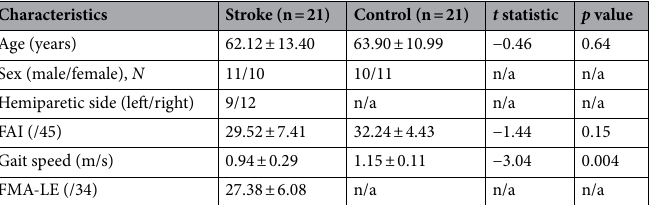
Table 1. Participant characteristics. All data is presented as mean ± standard deviation. FAI Frenchay activities index, FMA-LE Fugl-Meyer assessment of lower extremity, n/a not applicable.